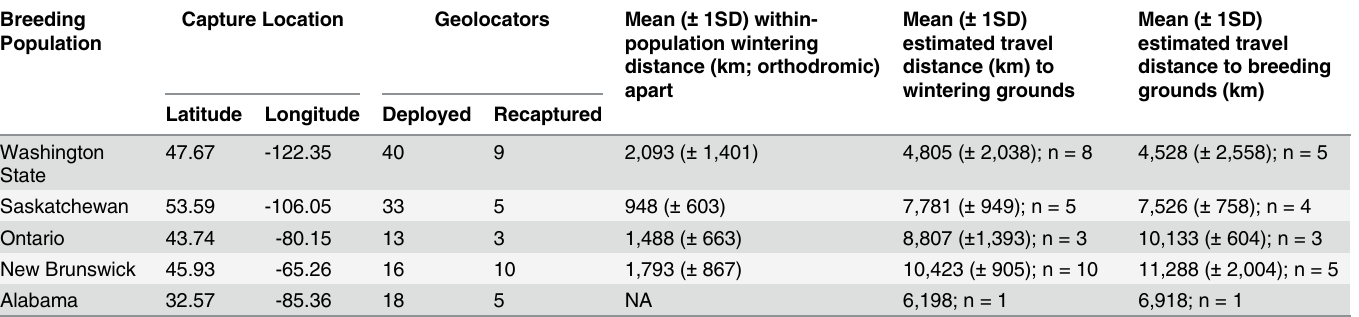
Table 1. Summary information, wintering distance and estimated fall and spring migration distances for barn swallows fit with archival light-level geolocators from five breeding populations, 2011 – 2013. Breeding